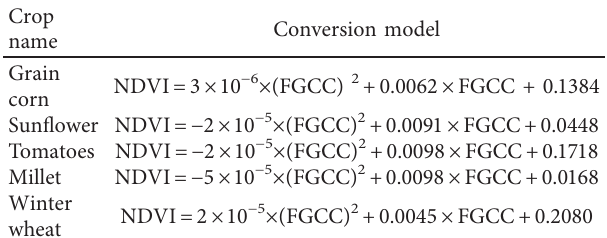
Table 2: FGCC model in NDVI conversion for the crops studied.